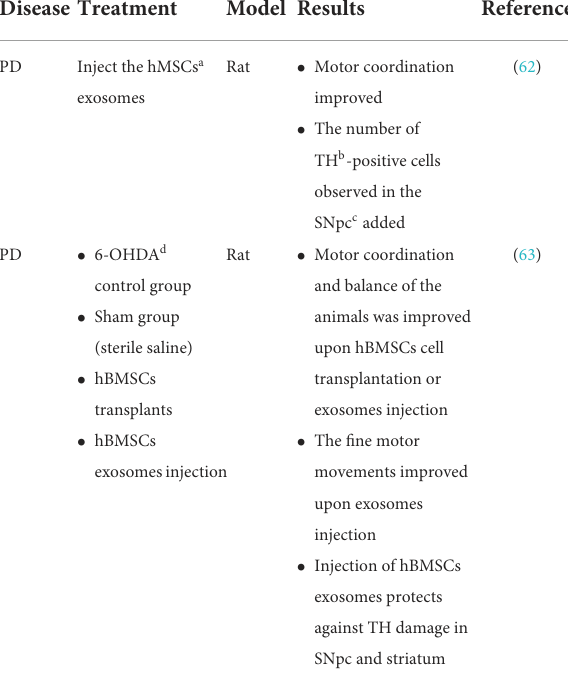
TABLE 2 Application of mesenchymal stem cell (MSC) therapy in the treatment of PD. Disease Treatment Model